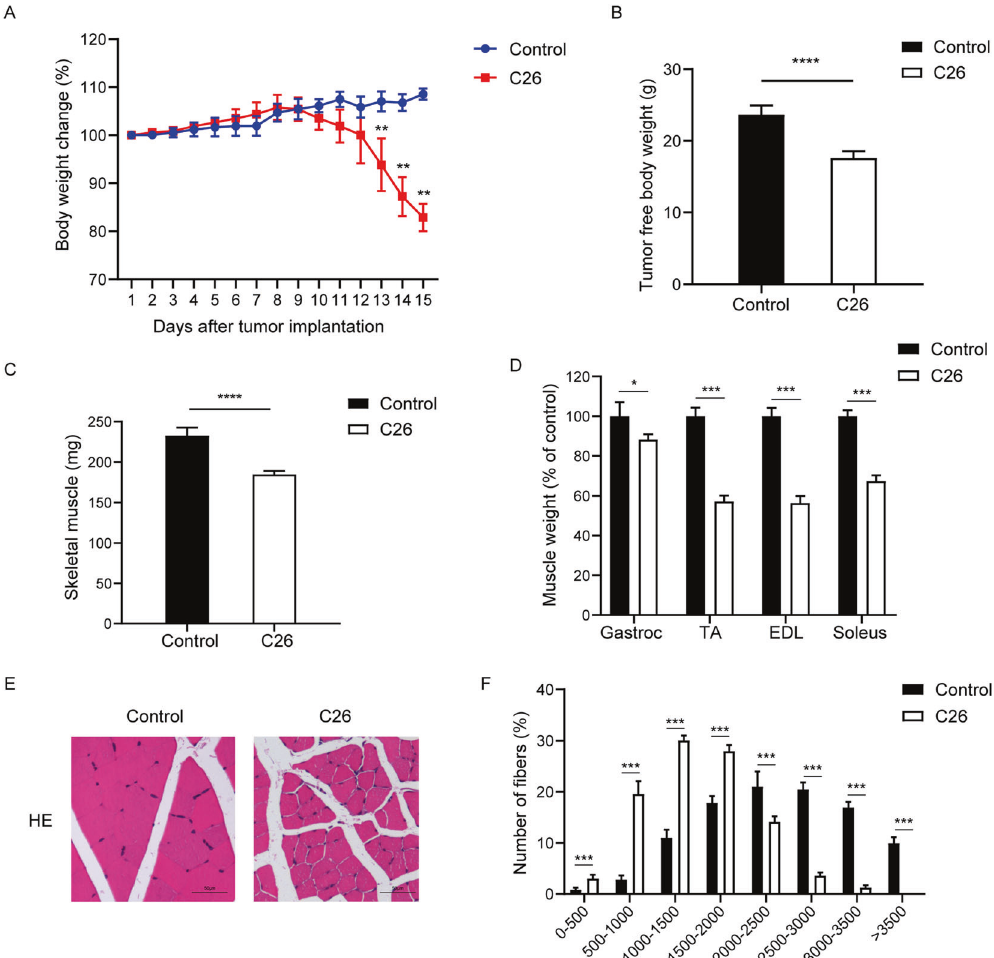
Fig. 1 Characterization of the colon-26 cancer cachexia model. A Bodyweight changes in normal mice and C26 tumor-bearing mice were monitored every day and traced for 15 days after tumor implantation. B Tumor-free body weights were measured after removal of the tumor at the end of the experiment. C The weight of total skeletal muscle of C26-xenografted mice was compared with that of normal control. D The weights of gastrocnemius (gastroc), tibialis anterior (TA), extensor digitorum longus (EDL), and soleus of C26-xenografted mice vs. nontumor- bearing control mice. E Representative haematoxylin and eosin (H&E) staining showing the morphological changes in the gastrocnemius of C26-xenografted and control mice. Scale bar: 50 μ m. F Fiber area frequency distribution of all fi bers from gastrocnemius muscles of control and C26-xenografted mice. Data are expressed as the mean ± SD, * P < 0.05, ** P < 0.01, *** P < 0.001, **** P < 0.0001, N =